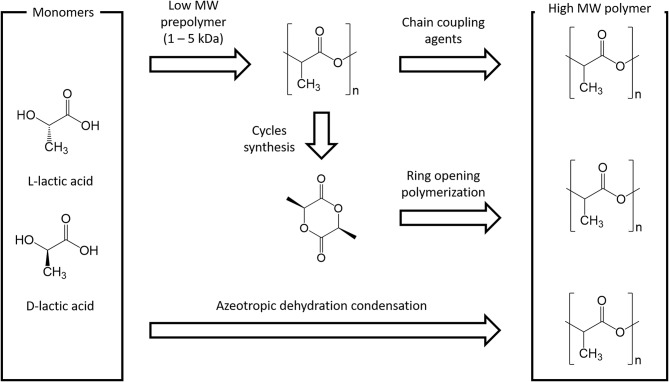
Main PLA production routes.